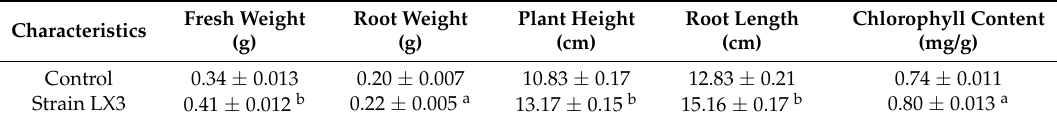
Table 2. Barley growth in the water with and without addition of culture fluid after 10